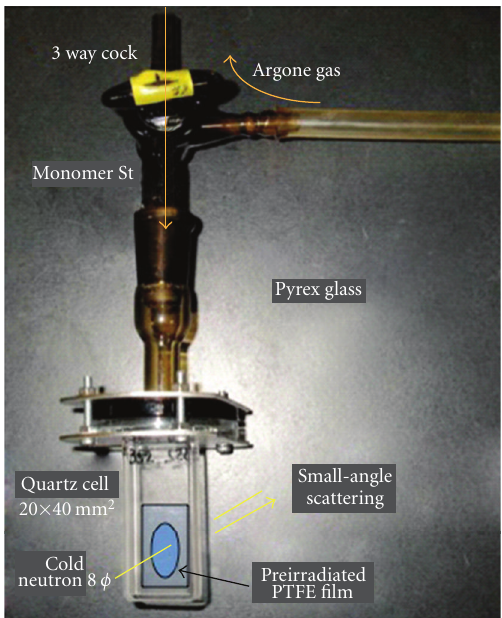
Figure 2: A picture of sample cell specially designed for in situ and real-time small-angle neutron scattering in order to observe Preirradiation graft polymerization on PTFE films.